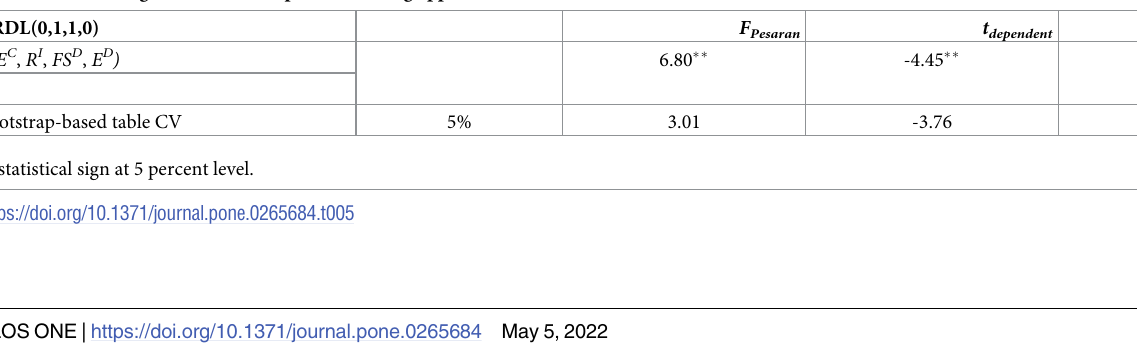
Table 5. The findings of the Bootstrap ARDL testing approach.